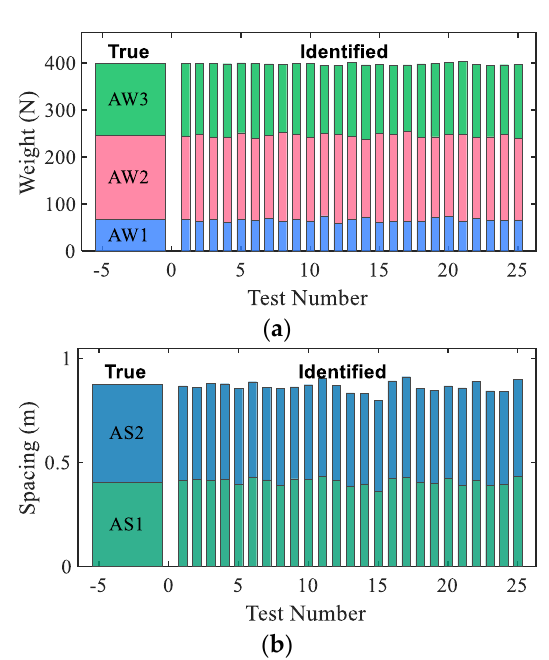
Figure 16. Identified results: ( a ) axle weights and ( b ) axle spacing.